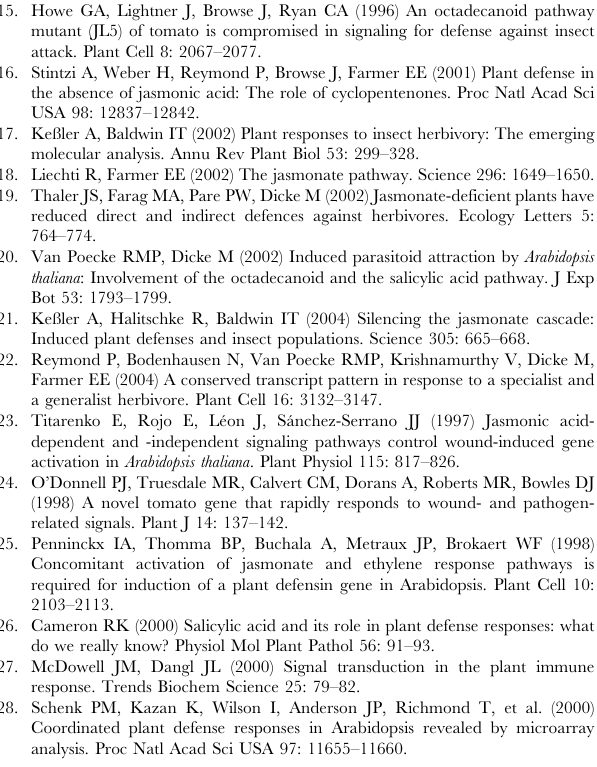
Table S5 Cross species comparison for differences in transcript levels and patterns between A. thaliana and B. divaricarpa. ‘GenePair’ refers to pairs of array features representing the same B. divaricarpa and A. thaliana cDNAs, based on best BLAST ‘MRNA*TRT’ are P-values for effects in ANOVA, and